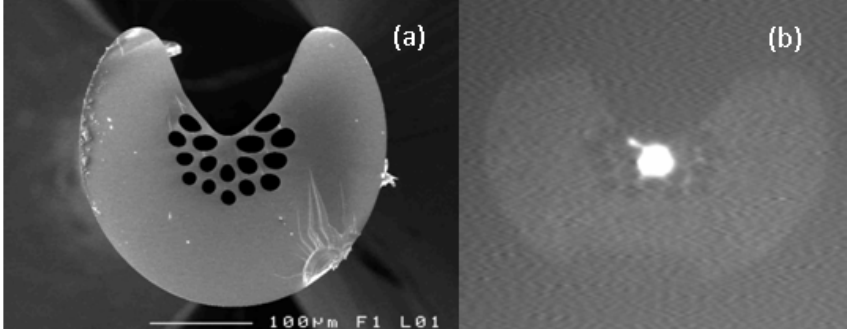
Figure 7. AsSe based microstructured exposed core fiber: ( a ) SEM micrographs of the. Fiber, external diameter d = 290 μ m, core diameter d 1.55 µm showing the light confinement in the exposed